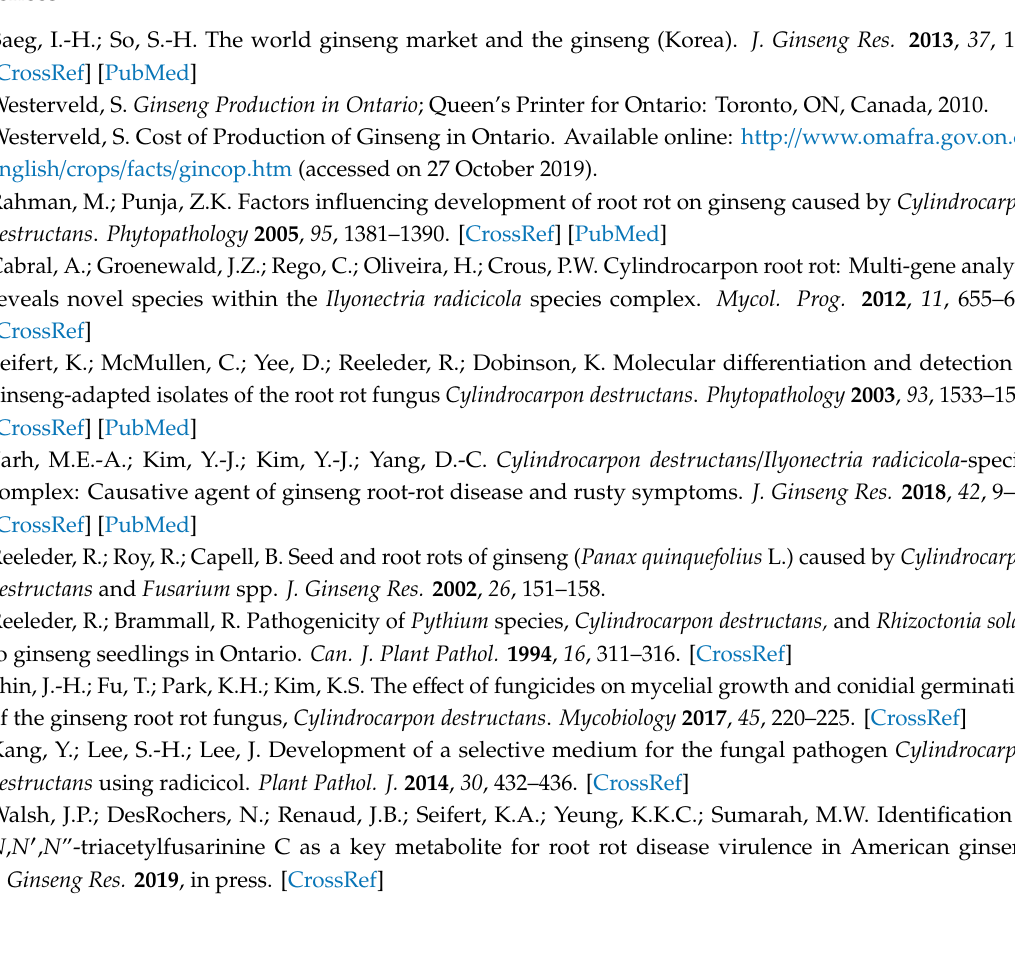
Figure S1: PCA plots with QC samples included. (A) negative ionization mode. (B) positive ionization mode, Table S1: Most abundant metabolites by peak area in positive ionization mode, produced by virulent strains of Ilyonectria , Table S2: Most abundant metabolites by peak area in negative ionization mode, produced by virulent strains of Ilyonectria. Text S1: Parameters for xcms processing, Data S1: These data are available at